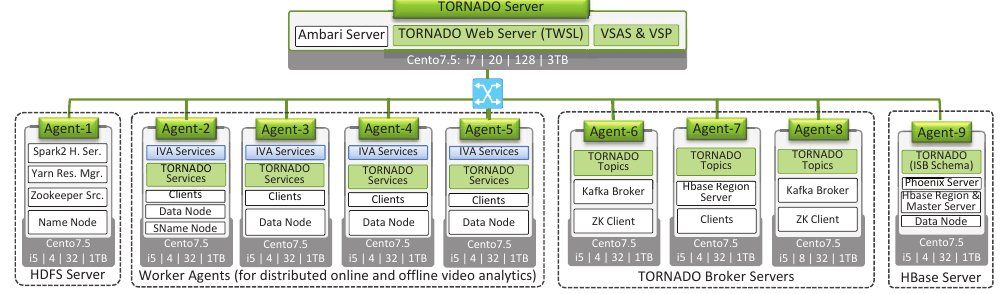
Figure 13. TORNADO Cluster.